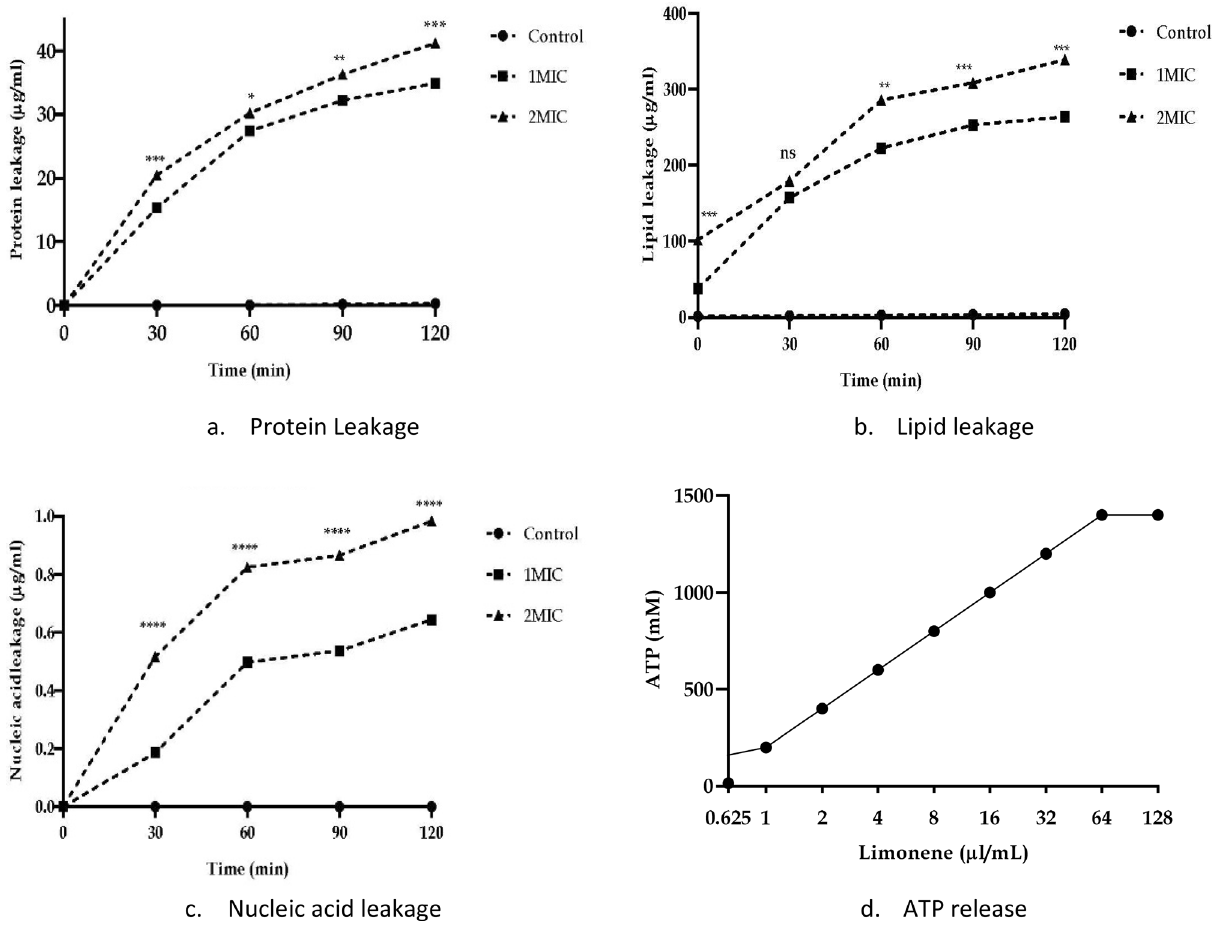
Figure 7. Effect of limonene on leakage of ( a ) protein, ( b ) lipid, ( c ) nucleic acid and ( d ) ATP in Escherichia